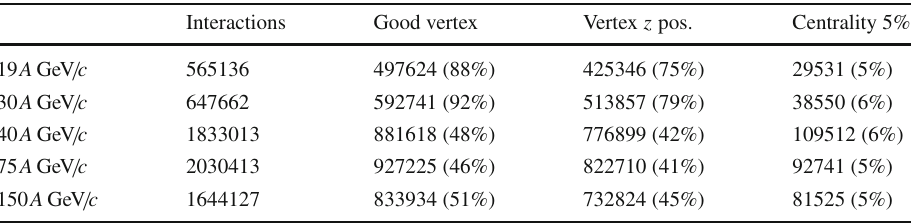
before and after cuts. See text for explanation of the columns